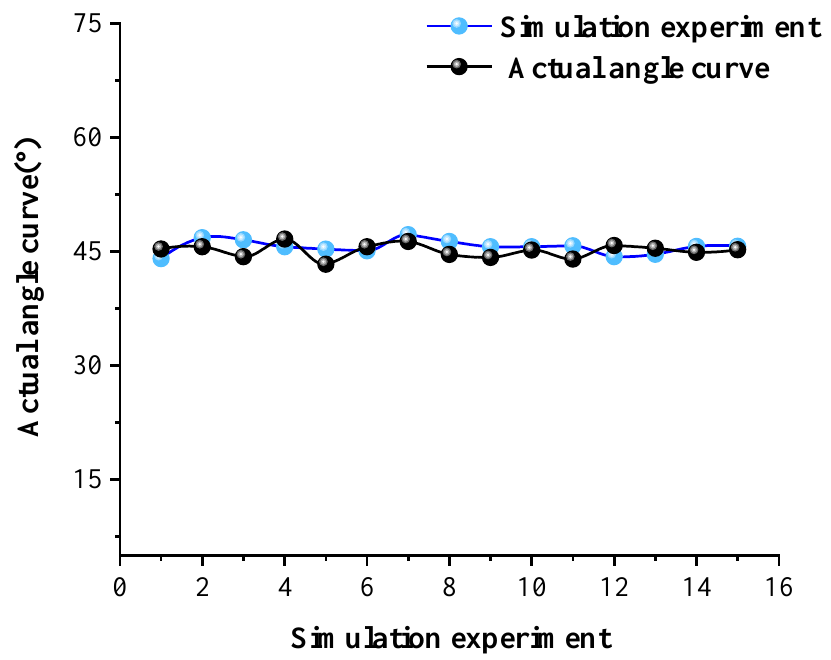
Figure 13. Simulation stacking ( a ) and actual stacking ( b ).